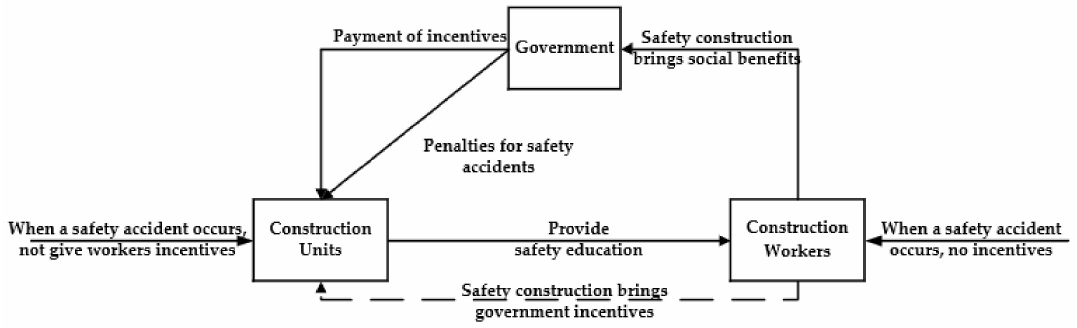
Figure 1. Tripartite Relationship Diagram of Government–Construction Unit–Construction